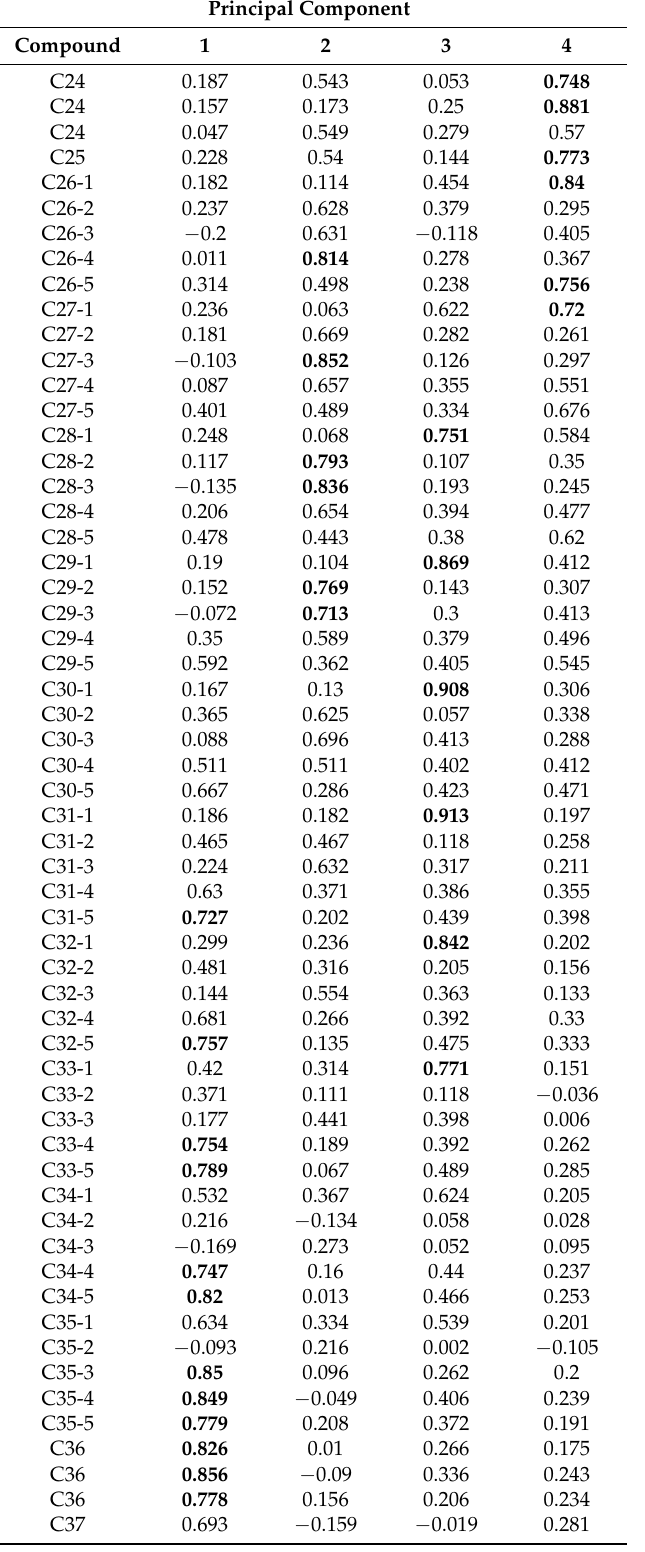
Table 2. Rotated component matrix for age effects on semivolatile compounds in house sparrows. All compounds are monoesters. The labeling system uniquely identifies each compound by the total number of carbon atoms it contains and (when applicable) its placement in the repeated pattern shown in Figure 1. Highly significant values ( ≥ 0.7) are in